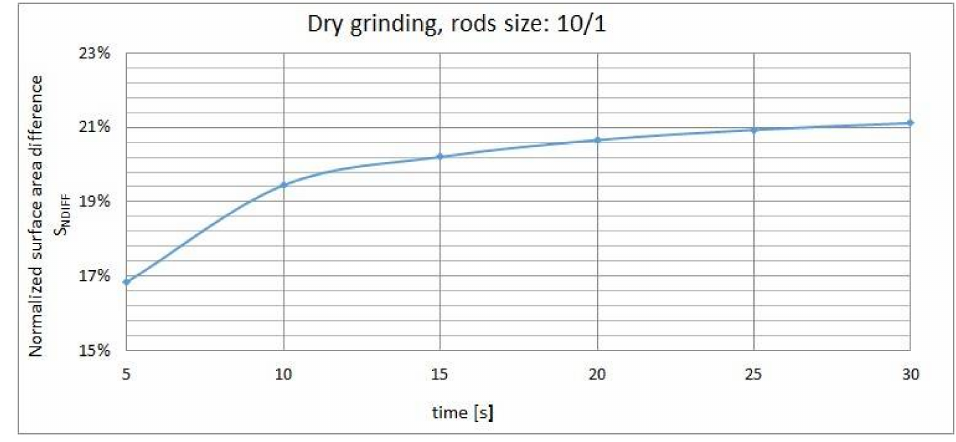
Figure 12. Comparison of S NDIFF factor for wet grinding with 10/1